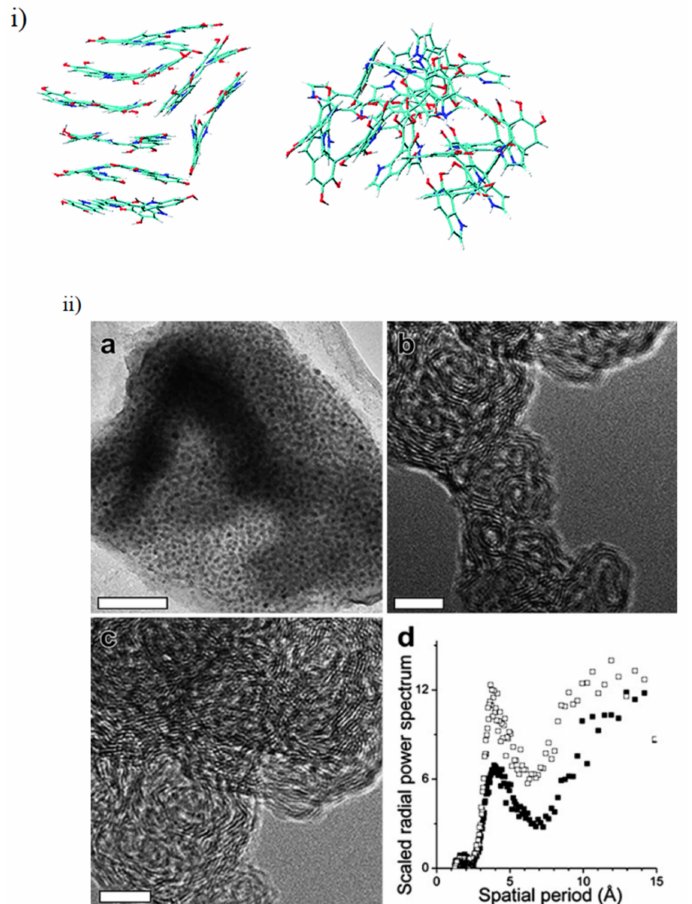
Figure 5. ( i ) A model stacked oligomeric structure proposed for melanin. Figure adapted with permission from C. Chen, F. J. Martin-Martinez, G. S. Jung and M. J. Buehler, Chem. Sci. , 2017, 8, 1631 under Creative Commons Attribution—Published by The Royal Society of Chemistry [22]. ( ii ) Real space images from TEM showing the stacking of the oligomers in both synthetic biomimetic versions and natural sources of melanin are also depicted. ( a ) Depicted is a low-resolution bright field transmission electron micrograph of synthetic melanin (scale bar: 50 nm). ( b ) A high-resolution bright field transmission electron micrograph of synthetic melanin (scale bar: 5 nm). ( c ) A high-resolution bright field transmission electron micrograph of synthetic melanin (scale bar: 5 nm). ( d ) A scaled radial power spectrum of ( b ) shown as solid black squares and ( c ) shown as open black squares. The narrow peaks in the spectra are centered at 3.9 A ◦ and 3.7 A ◦ , respectively, for the images ( b , c ). Adapted from [42] with permission from The Royal Society of